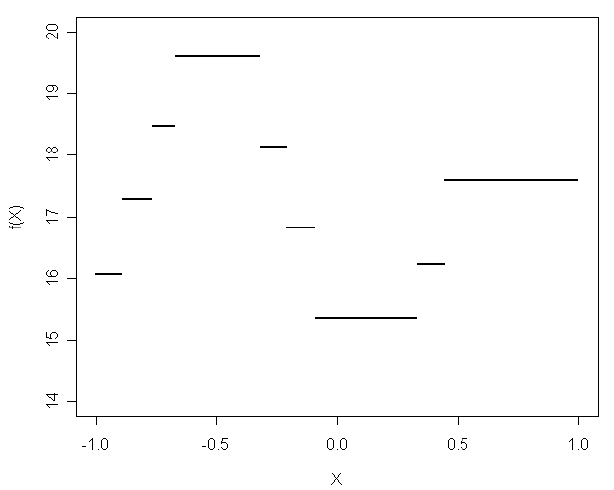
Figure 6 – Function f ( ⋅ ) of the model used in first simulation